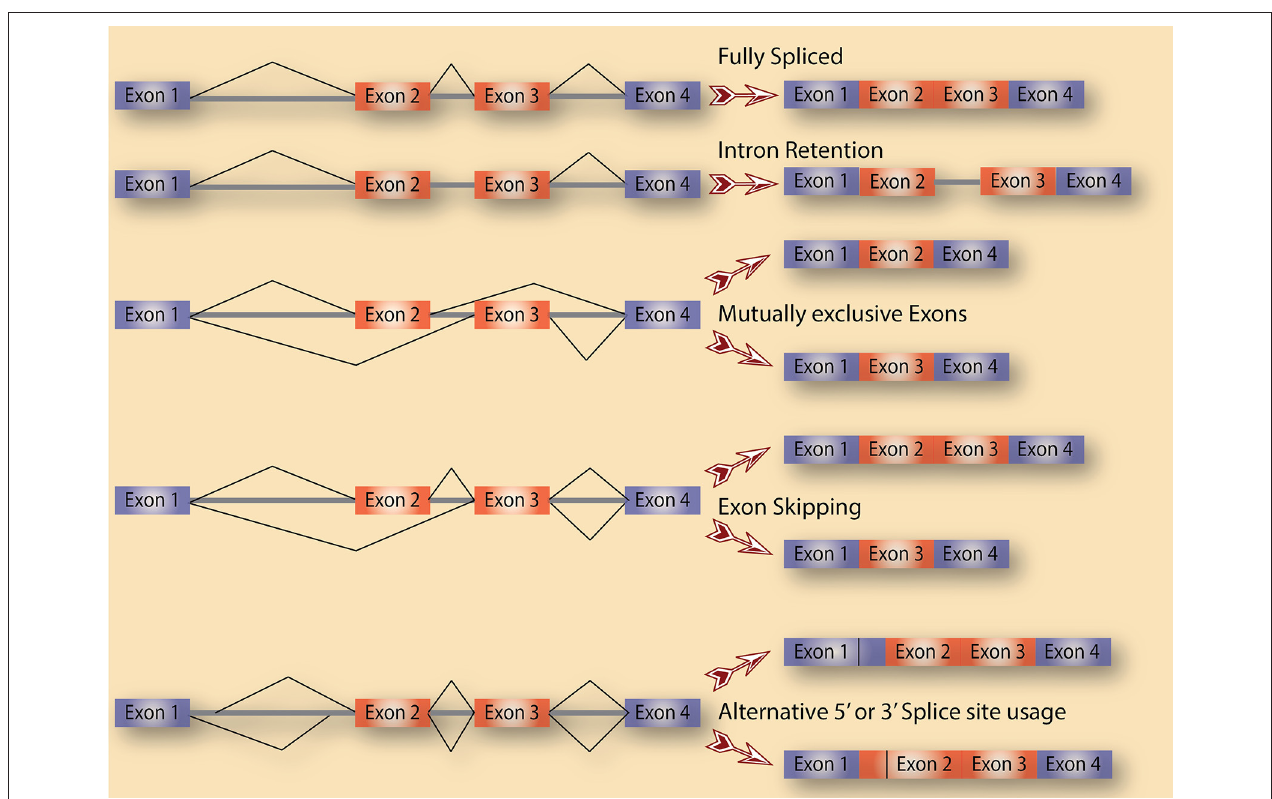
FIGURE 1 | Alternative splicing as a source of diversification. A schematic diagram that depicts the various types of alternative splicing events that potentially exist in